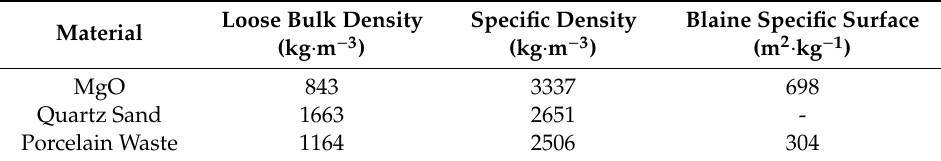
Table 3. Basic physical parameters of MgO, quartz sand, and porcelain waste.